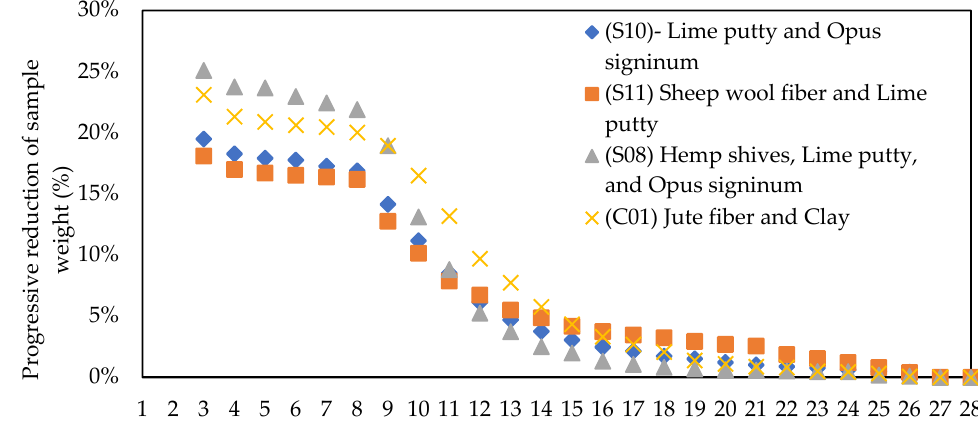
(Figure 1). In the following period, from the eighth to the fourteenth day, during which the samples were naturally dried, a rapid daily reduction of just under 3% was observed. For the remaining days, the decrease in weight was on average less than 0.2% daily.